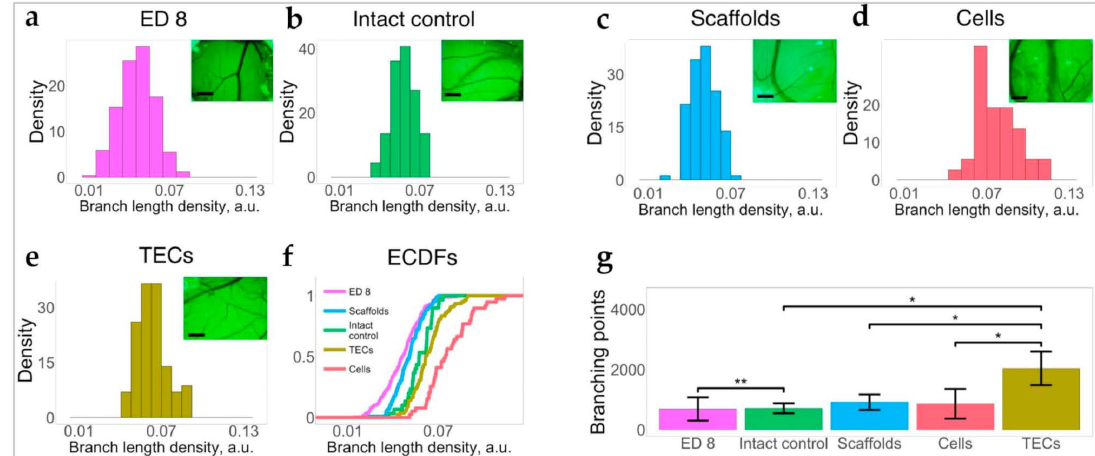
Figure 7. The angiogenic effects of 3D TECs, liver AOSSs (scaffolds), and suspensions of MDA-MB-231 cells (cells), grafted on a chick embryo CAMs compared to natural growth of CAM vasculature (intact control) in the period between ED8 and ED12 of the embryonic development. Histograms of branch length density of ( a ) CAM vasculature on the day of grafting (ED8), and in ( b ) intact control CAMs (ED12), ( c ) scaffolds, ( d ) cells, and ( e ) TECs. The insets are images of blood vessels located in the vicinity of grafted materials. Scale bars, 2 mm. ( f ) ECDFs of branch length density in CAMs on ED8 and in each group on ED12. ( g ) Comparison of the number of branching points (per unit area) in CAM blood vessels in the studied groups. Error bars indicate standard deviation. Stars denote the level of statistical significance by Mann–Whitney test: * p < 0.05 and ** p <